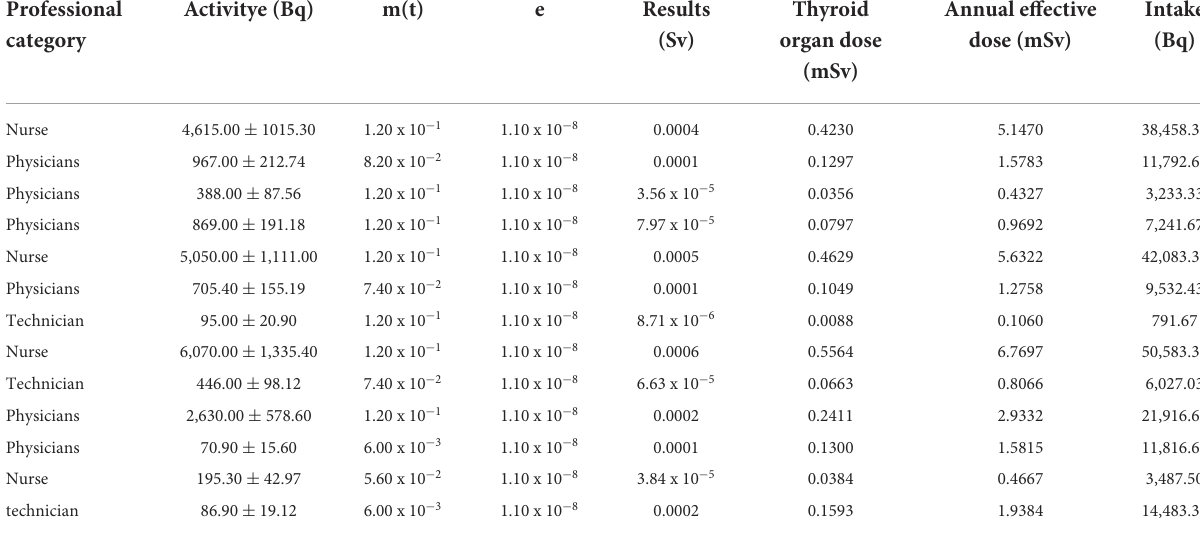
TABLE 6 Estimate of internal thyroid 131 I dose in